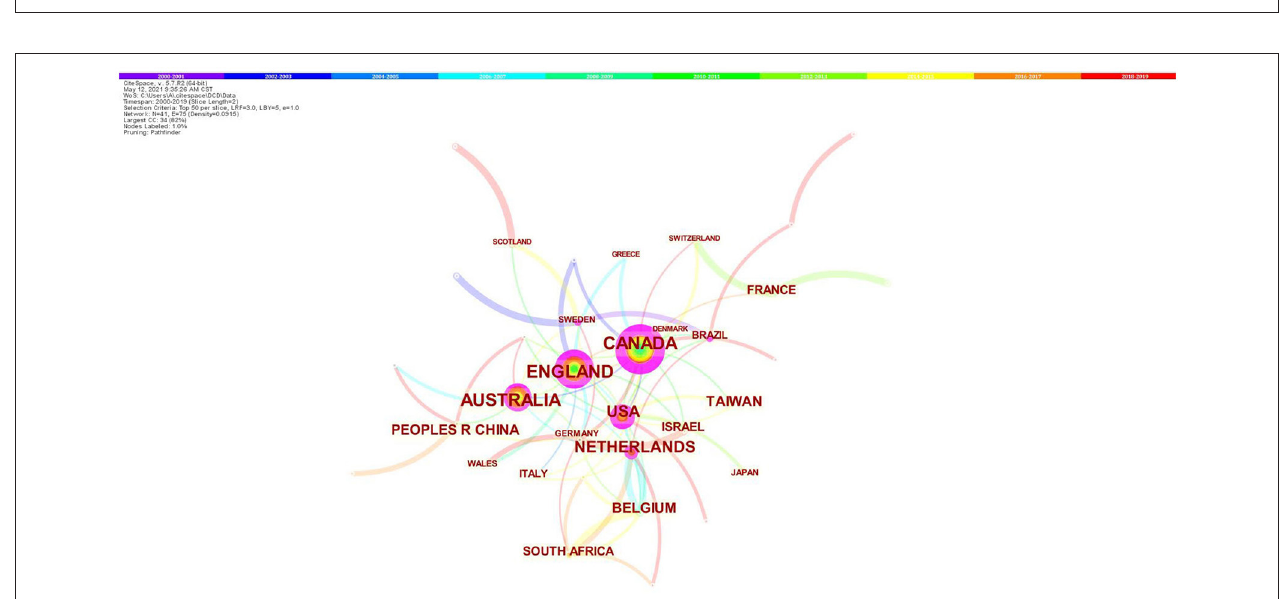
FIGURE 2 | Map of countries/regions cooperative relations in research of children with DCD, 2000–2019. The bigger the circle, the more original articles the country/region published. The shorter and thicker the connection line, the closer the relationship.